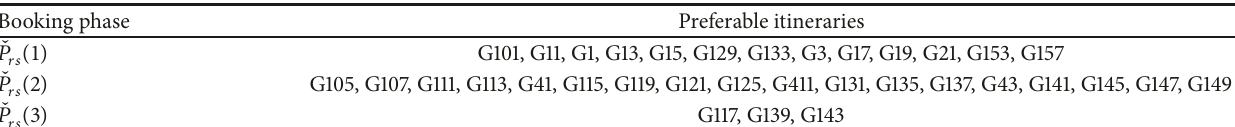
Table 4: The first booking phase scheme.